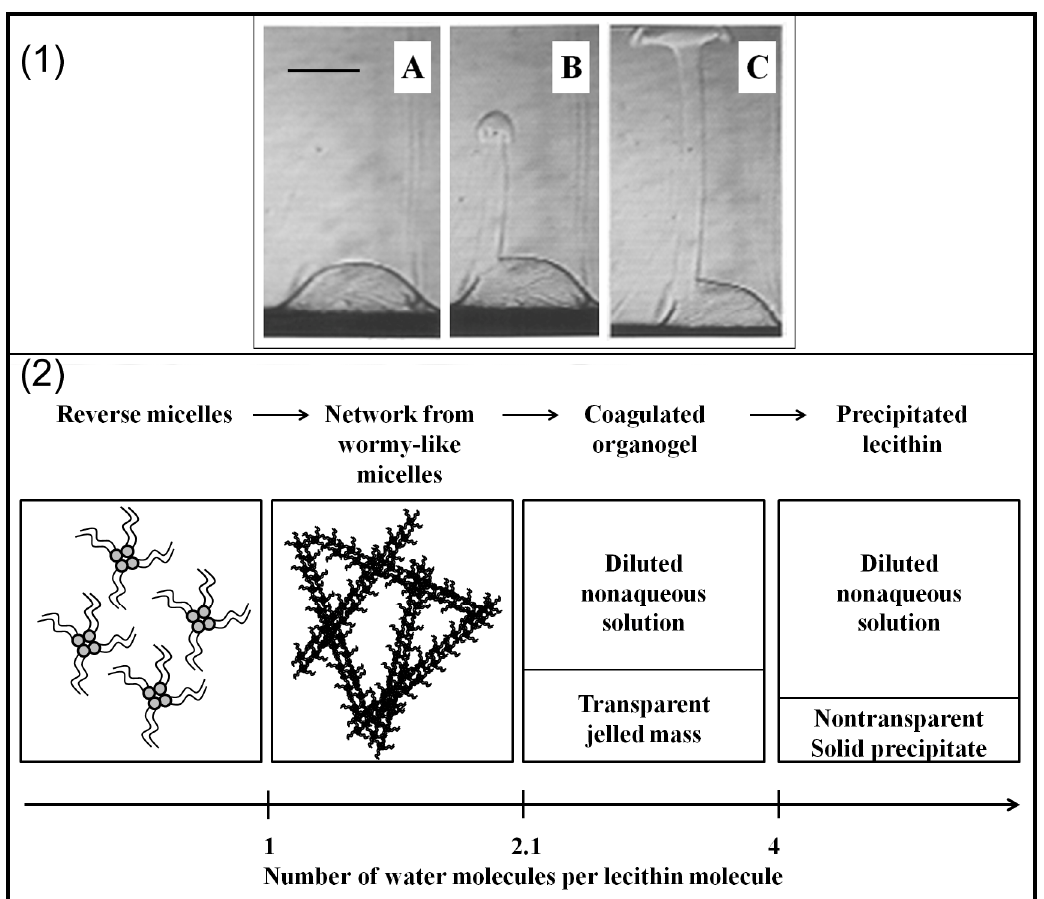
Figure 3. ( 1 ) Photographs showing a minor part of an aqueous solution at the bottom and a nonaqueous solution above. ( A – C ) Formation of an organogel diffusing from the interface through the oil phase; photographs were taken after 3.0, 3.5, and 3.8 min, respectively (the bar indicates 1 mm); ( 2 ) Schematic representation of the phase and pseudophase transitions in a 1% w / v lecithin solution after addition of water. Adapted with permission from Shchipunov and Schmiedel [68], Copyright (1996) American Chemical